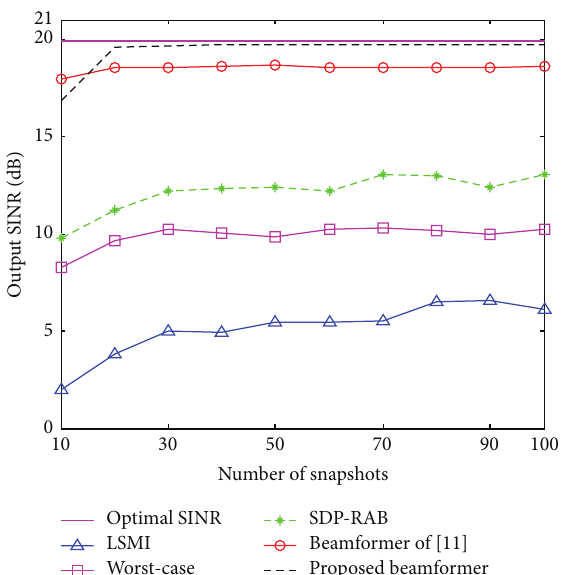
Figure 5: Output SINRs versus input SNR in the case of wavefront distortion.